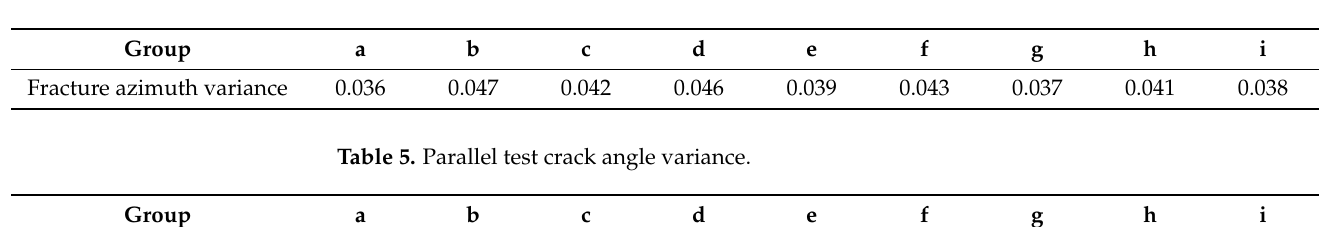
Table 4. Parallel test fracture azimuth variance.